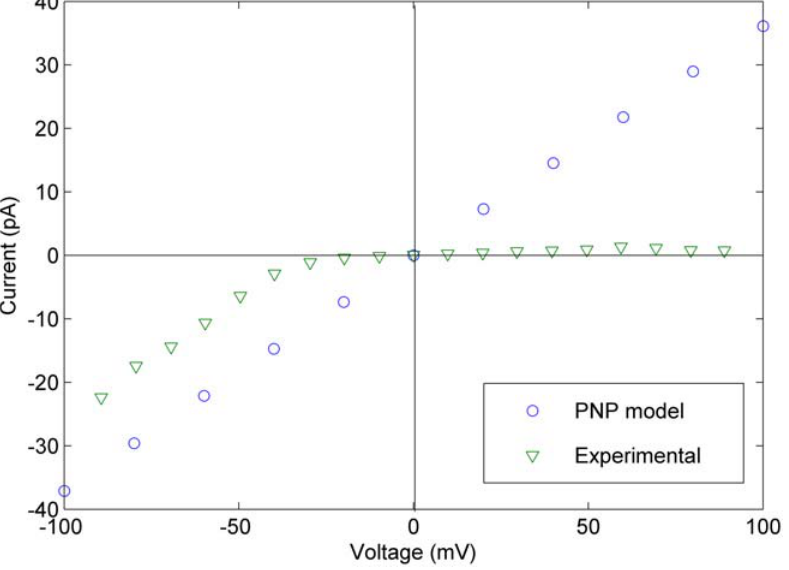
Figure 3. Comparison of I–V curves from the PNP model and experiments [ 19 ] . All data correspond to a snapshot at 93.5 ns of the NPT segment of the simulations of Langham and coworkers [17], using diffusion coefficient profile D4 (see Methods section). KCl salt bath concentrations were set to 0.1 M on both sides of the membrane in order to match experimental conditions.